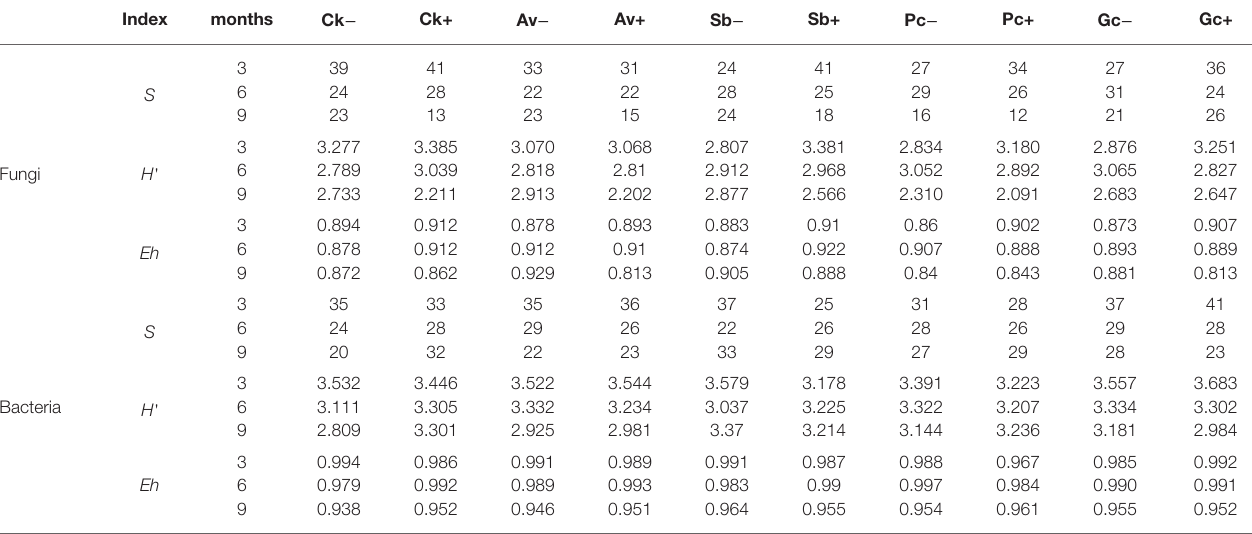
TABLE 1 | Shannon-Wiener index ( H ' ), richness ( S ), and evenness ( Eh ) of Pinus tabulaeformis rhizosphere bacteria and fungi in the different treatments at 3, 6, and 9 months after PWN